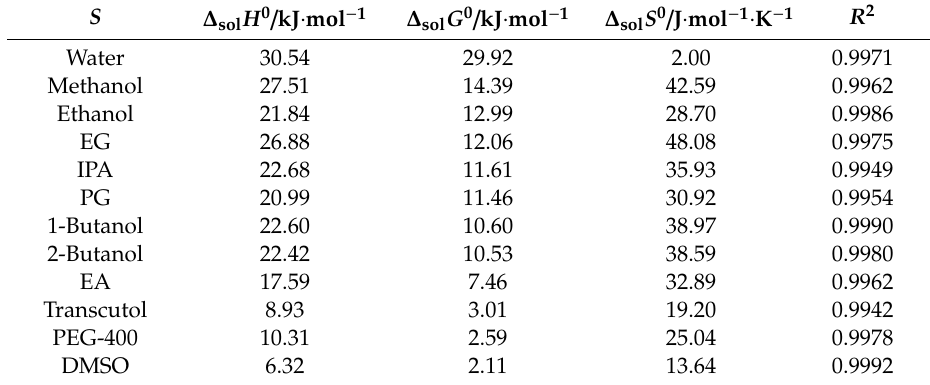
Table 5. Thermodynamic quantities ( ∆ sol H 0 , ∆ sol G 0 and ∆ sol S 0 ) and R 2 values for the PPD dissolution in various neat solvents ( S )